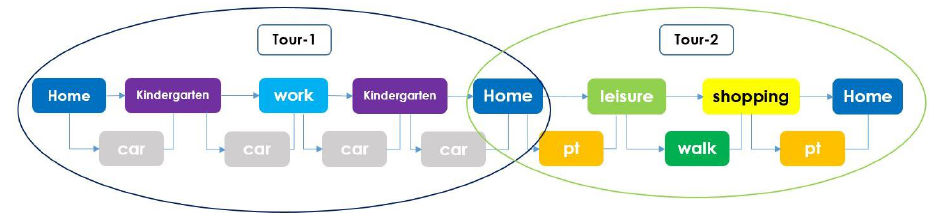
Figure 22. Activity plan (HKWKHLShH): the first tour represents a return trip between home and work via the kindergarten using the car as a mode; the second tour represents a home-tour passing by leisure and shopping places, and the used modes are a combination between pt and walk. To avoid the conflict between the activities from the same type ( home , kindergarten ) during the illustration, these activities are renamed (see Figure 23).